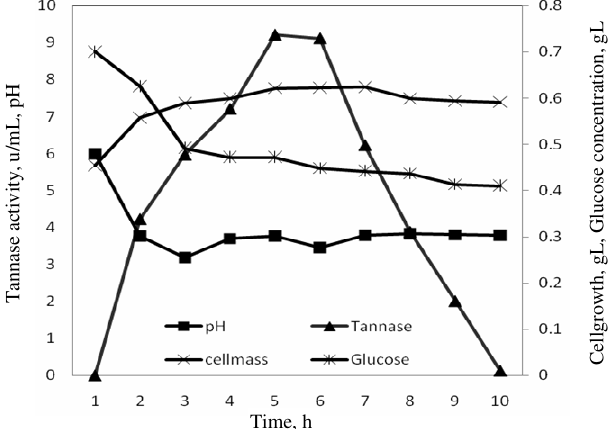
Figure 5. Profile of tannase activity ( (cid:1) ), glucose concentration ( (cid:1) ), pH ( (cid:1) ), and cell mass concentration ( (cid:2) ) in batch tannase fermentation by Lactobacillus plantarum